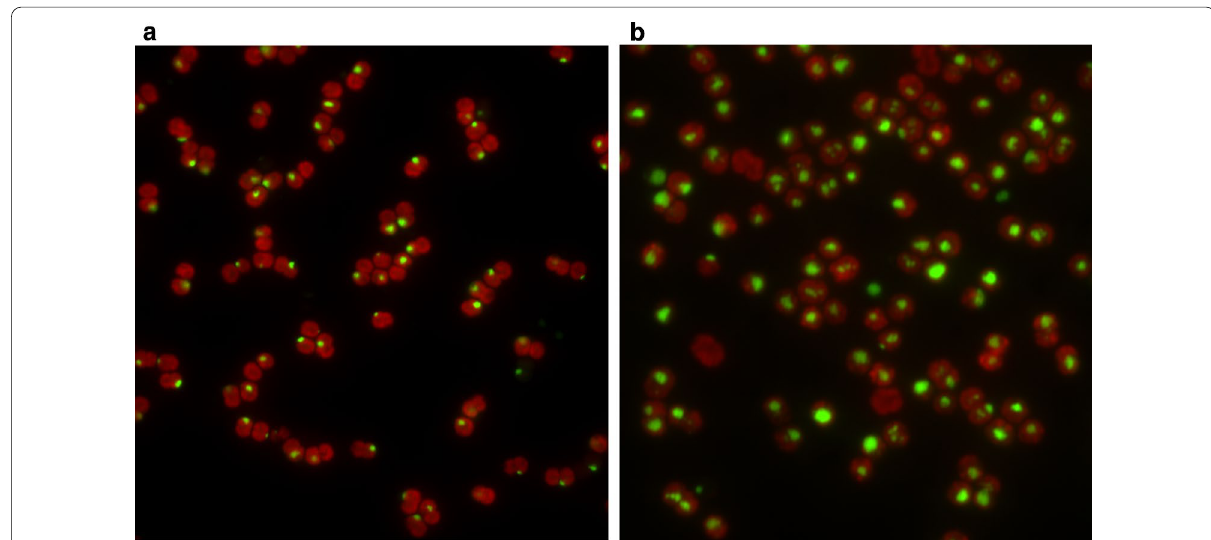
Fig. 5 Location of RPE Rubisco in the Synechocystis strain. The fluorescent signal of RPE-GFP ( a ) and 6RBCL-GFP ( b ). GFP was fused to the C-terminal of RPE Rubisco or the large subunit of 6RBC Rubisco. RPE-GFP and 6RBCL-GFP were individually expressed in the WT strain. The foci of 6RBC-GFP represents the location of mature carboxysomes. The red fluorescence of endogenous chlorophyll-a was used to indicate the shape of the whole